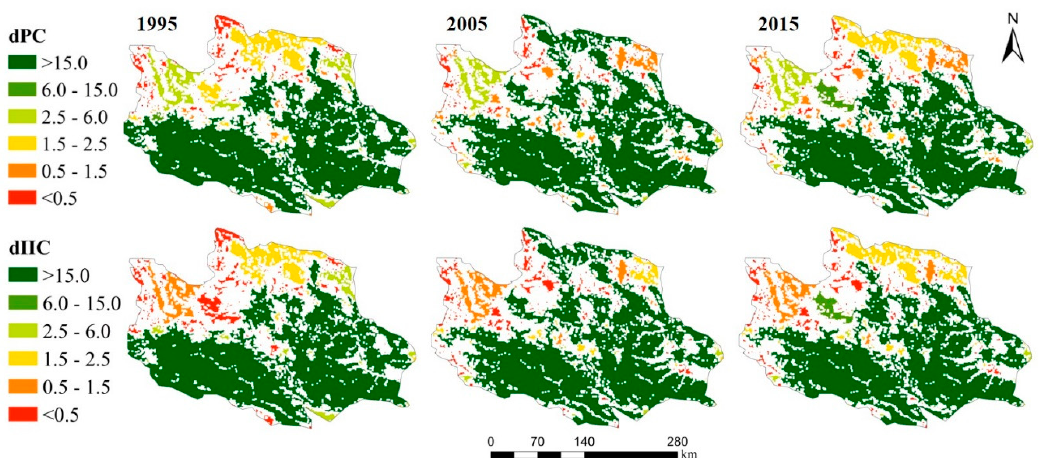
Figure 4. The important levels of natural habitats in different periods. dPC and dIIC represent the importance of patches calculated by probability of connectivity (PC) and integral index of connectivity (IIC), respectively.